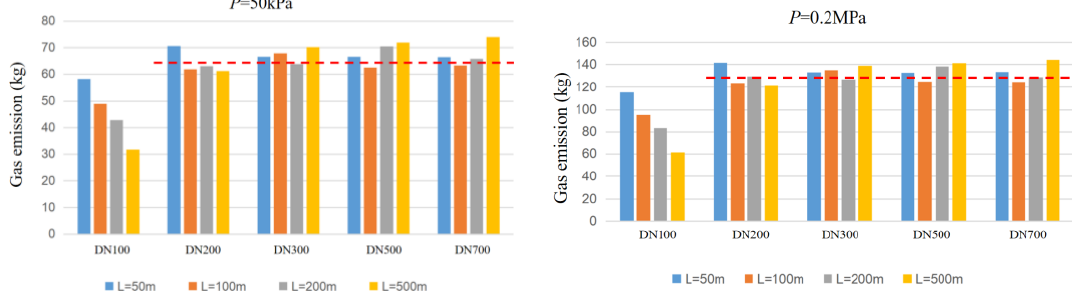
Figure 4. Calculated gas emission of purging for different pressure and pipe length/diameter.